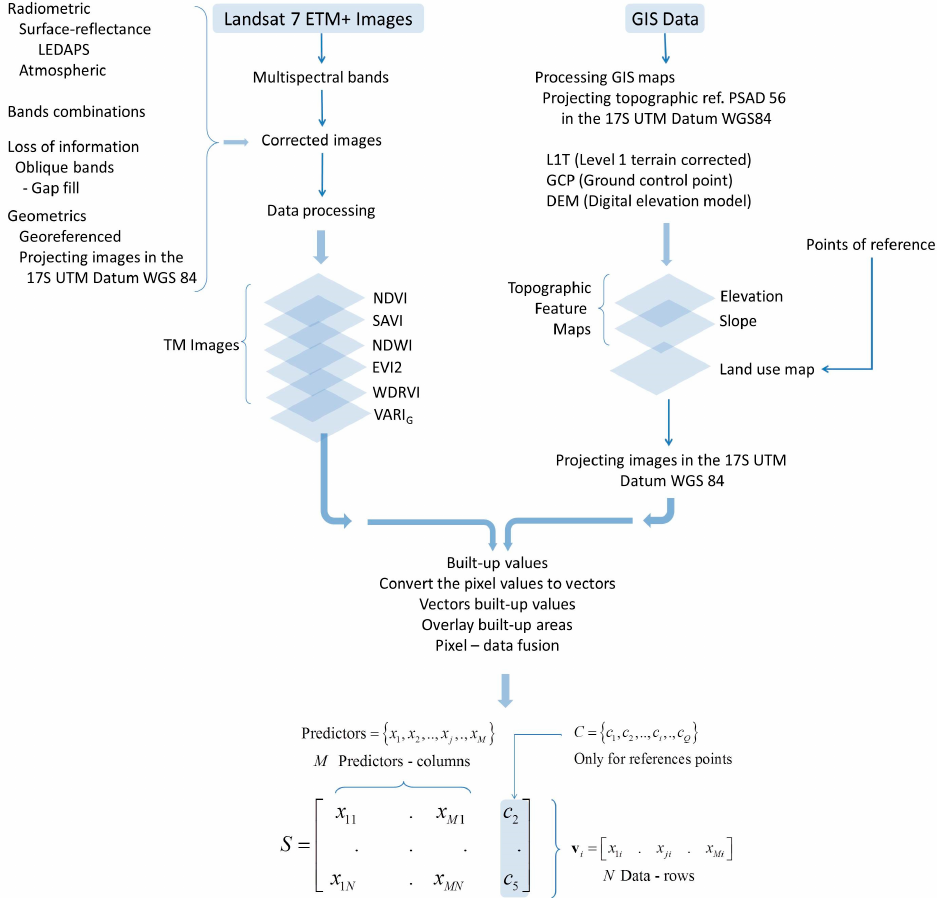
Figure 2. The processing of the Landsat 7 ETM+ images.